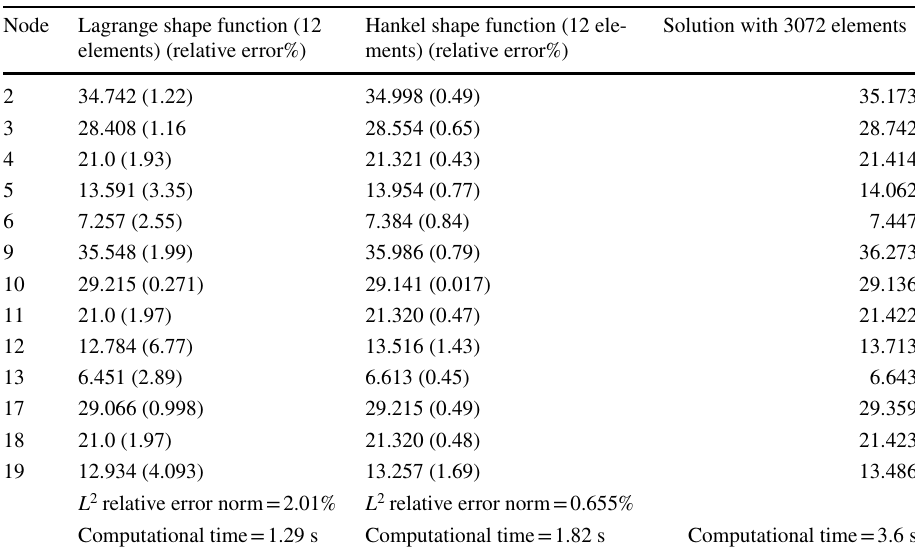
Node Lagrange shape function (12 elements) (relative